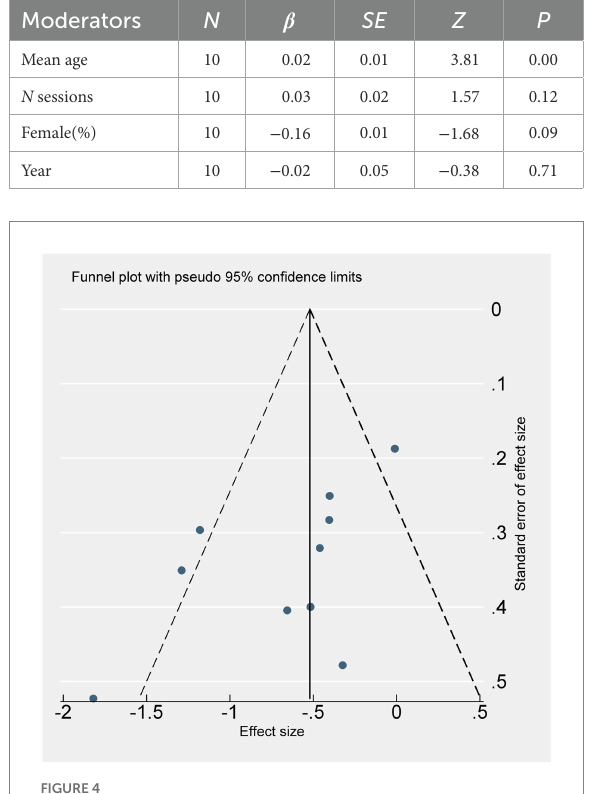
FIGURE 4 Funnel plot shows the publication bias and the heterogeneity. Scatter distribution suggests that there may be publication bias. Three studies fall outside the funnel chart, suggesting that there may be